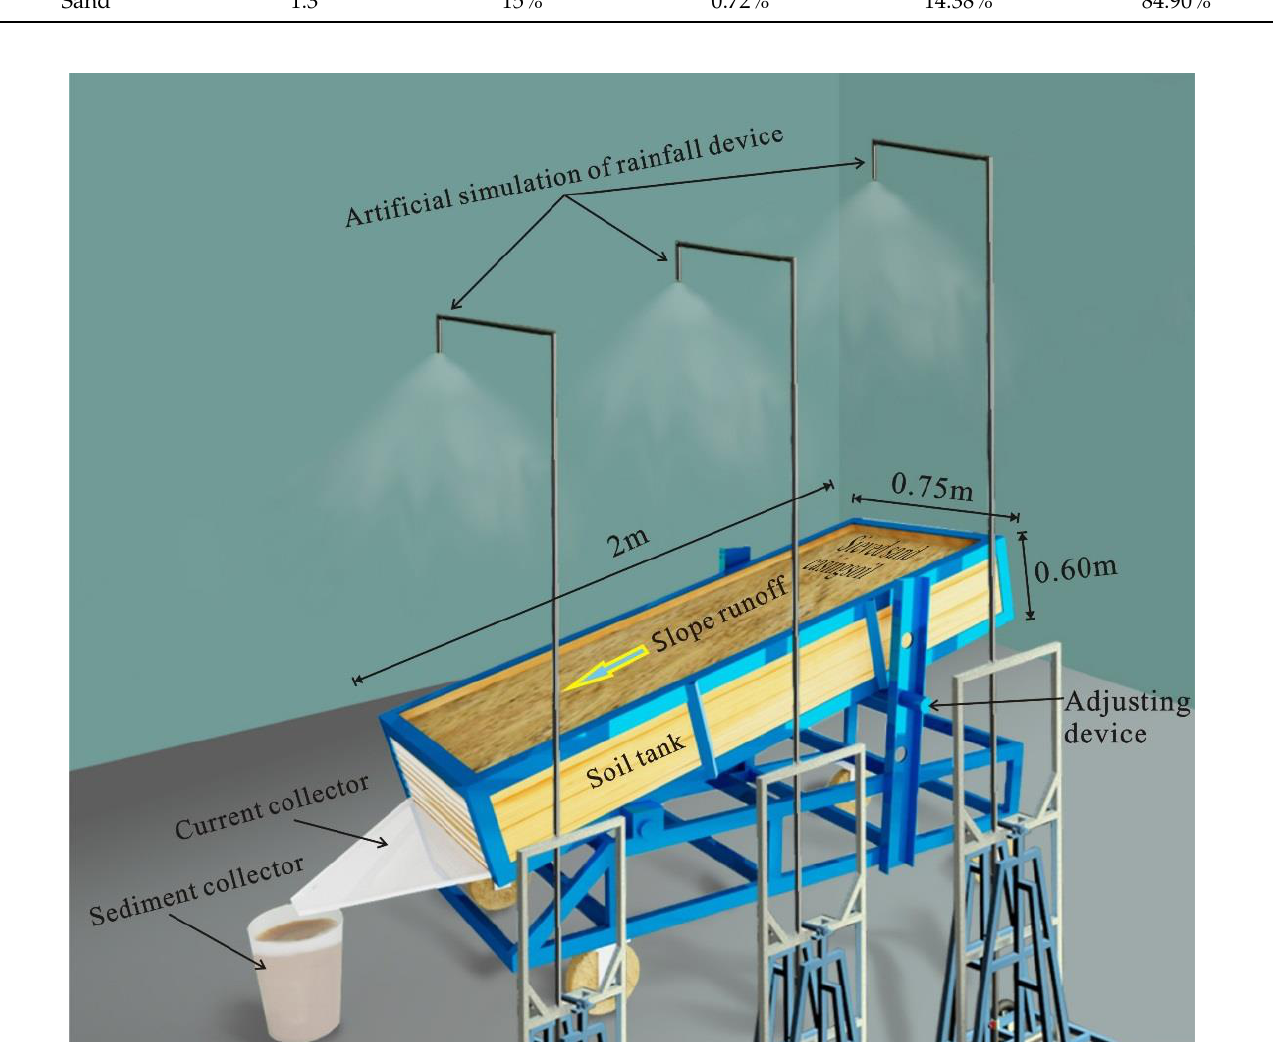
Figure 1. Schematic diagram of test soil trough.